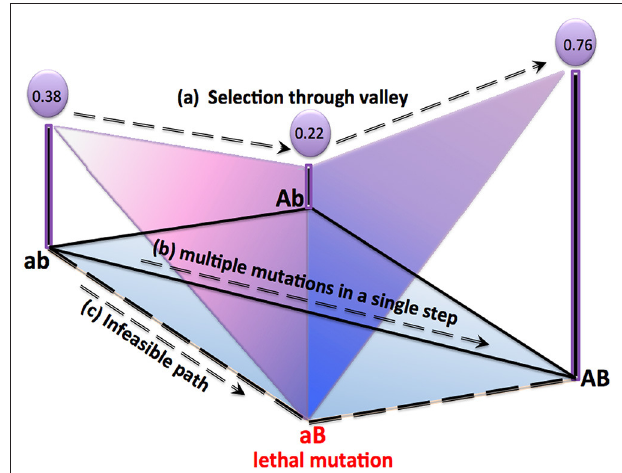
FIGURE 1 | Experimentally observed yet lesser studied paths for a 2-string genotype are shown in above representation of a realistic fitness landscape. All possible mutations for a 2-string genotype can be represented as “ ab ,” “ AB ,” “ Ab ,” and “ aB .” Here “ aB ” is presumed as lethal. Fitness value of each genotype resulting from epistatic interaction is also mentioned. Apart from well-known adaptive walks, three other possible evolutionary paths are: (a) Non-adaptive path passing through a valley “ ab ” → “ Ab ” → “ AB ” as studied in Poelwijk et al. [8] and Wang et al. [9], (b) multiple mutations in a single step as studied in Refs. [ 24, 32], and, (c) infeasible path leading to the lethal mutation “ aB ” [ 33]. Topologically inspired walks on fitness landscapes with heterogeneous connectivities can successfully model (a) , (b) , and (c)